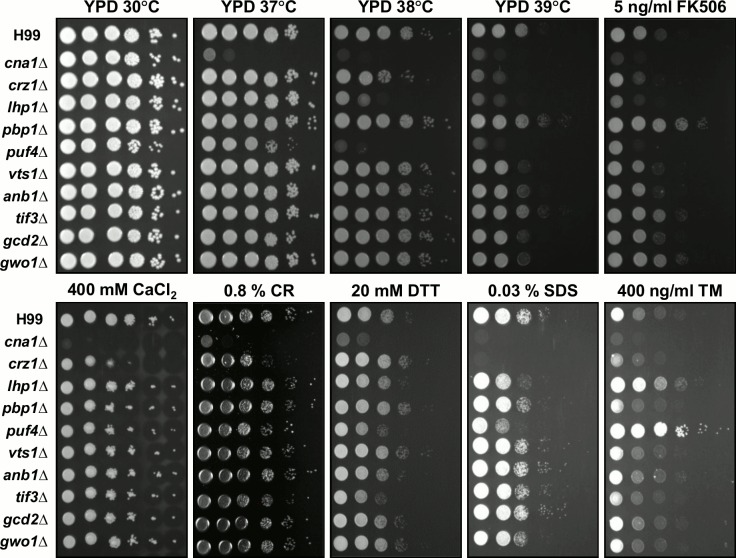
Phenotypes of the calcineurin target mutants exposed to various stresses.Spot dilution assays with WT (H99), cna1Δ (HP243), crz1Δ (HP235), lhp1Δ (HP22), pbp1Δ (HP6), puf4Δ (HP17), vts1Δ (HP24), anb1Δ (HP36), tif3Δ (HP9), gcd2Δ (HP28), and gwo1Δ (HP1) mutants were performed under several stress conditions as indicated. Strain cultures were incubated overnight, serially diluted 10-fold, and plated on YPD medium without or with FK506, CaCl2, Congo red (CR), dithiothreitol (DTT), sodium dodecyl sulfate (SDS), and tunicamycin (TM) at the indicated concentrations. Cells were incubated for 2 to 3 days at 30°C, 37°C, 38°C, or 39°C as indicated and all cultures with compound additions were incubated at 30°C. Results shown are representative of two independent experimental replicates.